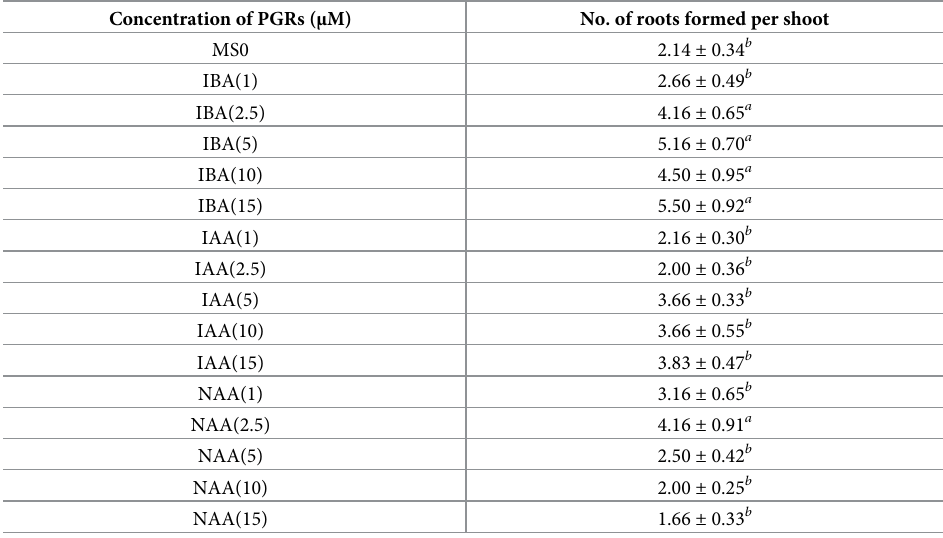
Table 4. Rooting of microshoots on solid MS medium supplemented with different auxins.